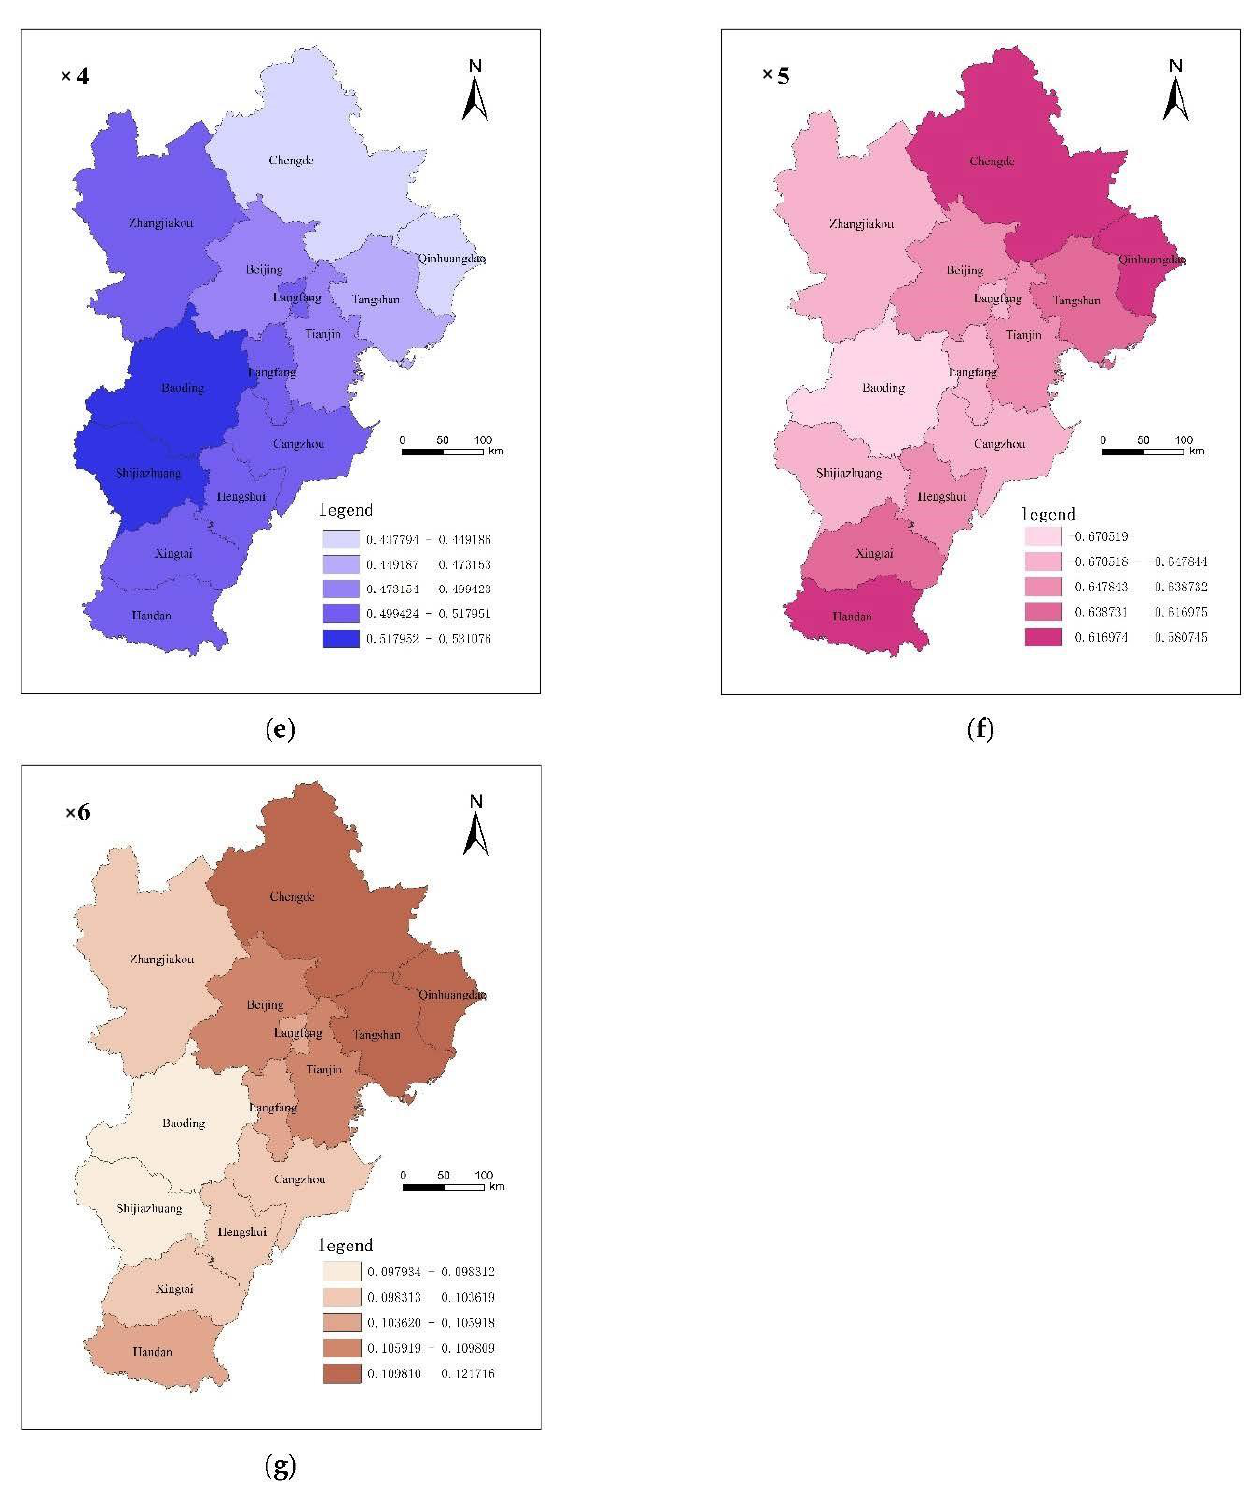
Figure 5. ( a ) Geographical location map of Beijing–Tianjin–Hebei region; ( b ) Spatial heterogeneity of PGTWR regression coefficient of industrial structure; ( c ) Spatial heterogeneity of PGTWR regression coefficients of urbanization level; ( d ) Spatial heterogeneity of PGTWR regression coefficients of energy intensity; ( e ) Spatial heterogeneity of PGTWR regression coefficients of level of economic de- velopment; ( f ) Spatial heterogeneity of PGTWR regression coefficients of population size; ( g ) Spatial heterogeneity of